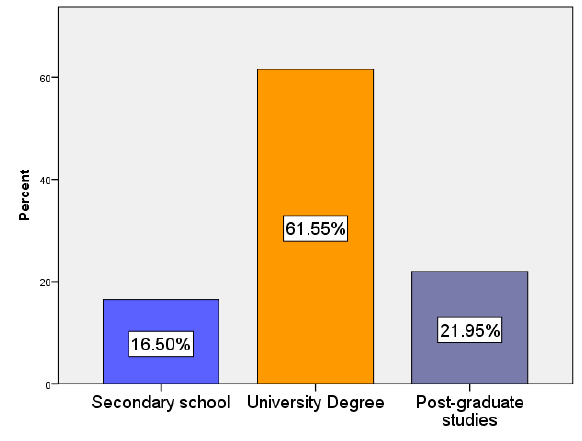
Figure 4. Education distribution.